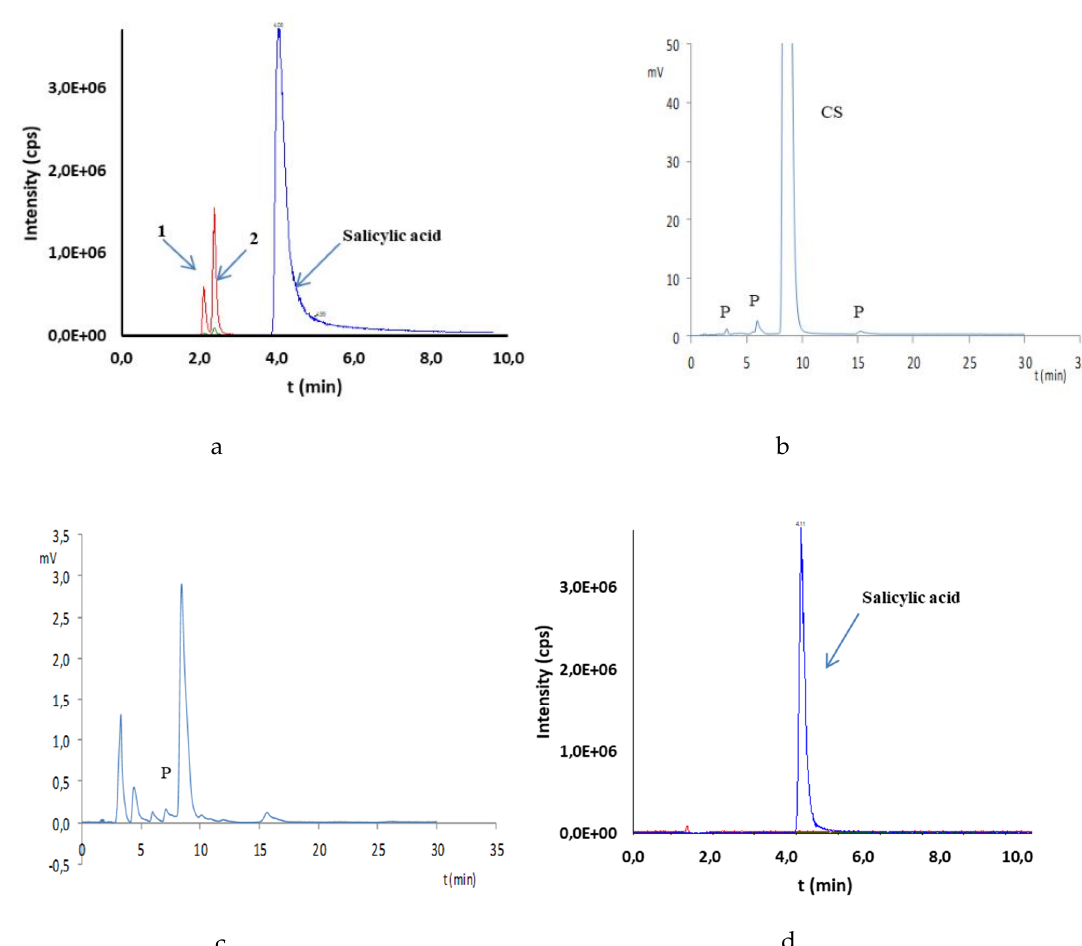
Figure 4. Analysis of CS solution (20 mg / mL) subjected to ( a ) HPLC-MS / MS after oxidation (10% H 2 O 2 , room temp. 24 h), ( b ) HPLC-UV after acidic hydrolysis (1 M HCl, 90 ◦ C, 24 h), ( c ) HPLC-UV after alkaline hydrolysis (1 M NaOH, 90 ◦ C, 24 h), and ( d ) HPLC-MS / MS after alkaline hydrolysis (1 M NaOH, 90 ◦ C, 24 h). 1—2,5-dihydroxybenzoic acid; 2—2,3-dihydroxybenzoic acid; CS—principal peak; P–unidentified products.